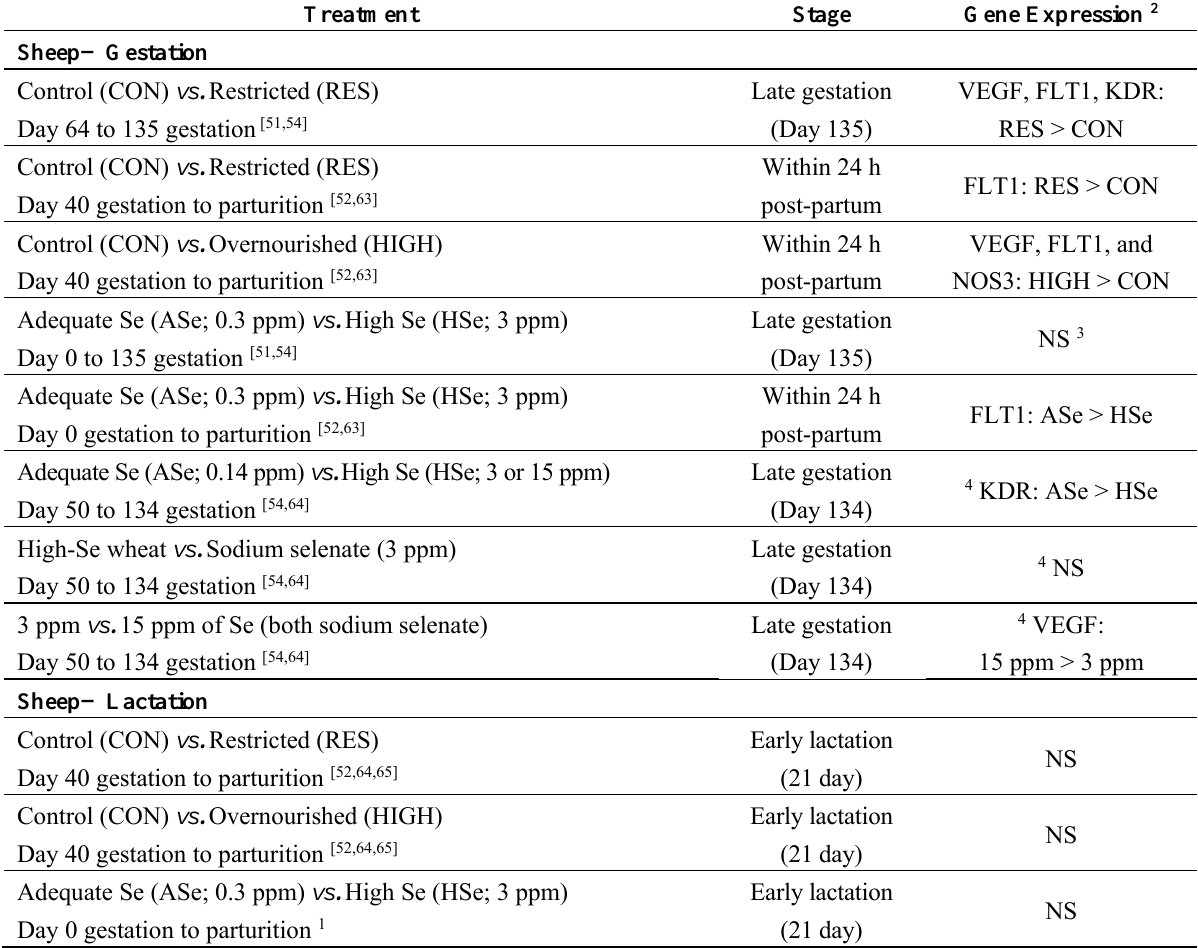
Table 4. Expression of VEGF and NO system mRNAs in the small intestine of ewes. Treatment Stage Gene Expression